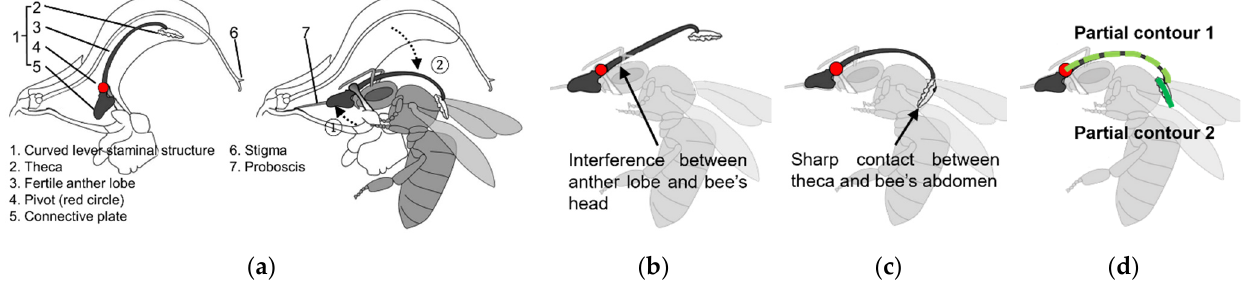
Figure 1. Schematic drawing of the lever mechanism in a Salvia pratensis flower and its interaction with a flower-visiting bee as depicted by Reith et al. [17]: ( a ) Longitudinal section of a flower and motions of the curved staminal lever; ( b ) a hypothetical straight-line staminal lever; ( c ) a hypothetical staminal lever where the theca has the same curvature as the anther lobe; ( d ) a real staminal lever composed of two partial contours. The partial contours 1 and 2 prevent interference with the bee’s head and avoid sharp contact between the theca and the bee’s abdomen, respectively.